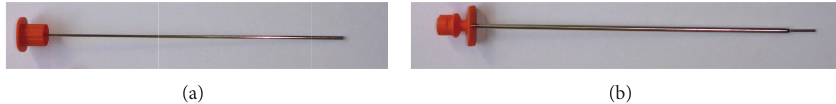
Figure 2: Bone cement injection cannula. The injection cannula (b) can be filled with 1.5mL of bone cement. With the pusher (a), the bone cement is poured in the cannulated screw and the surrounding vertebral body.